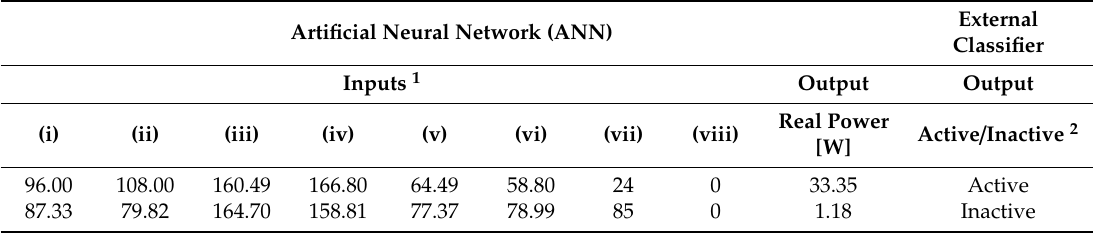
Table 1. Structure of dataset (sample data for the fridge in house no 1).